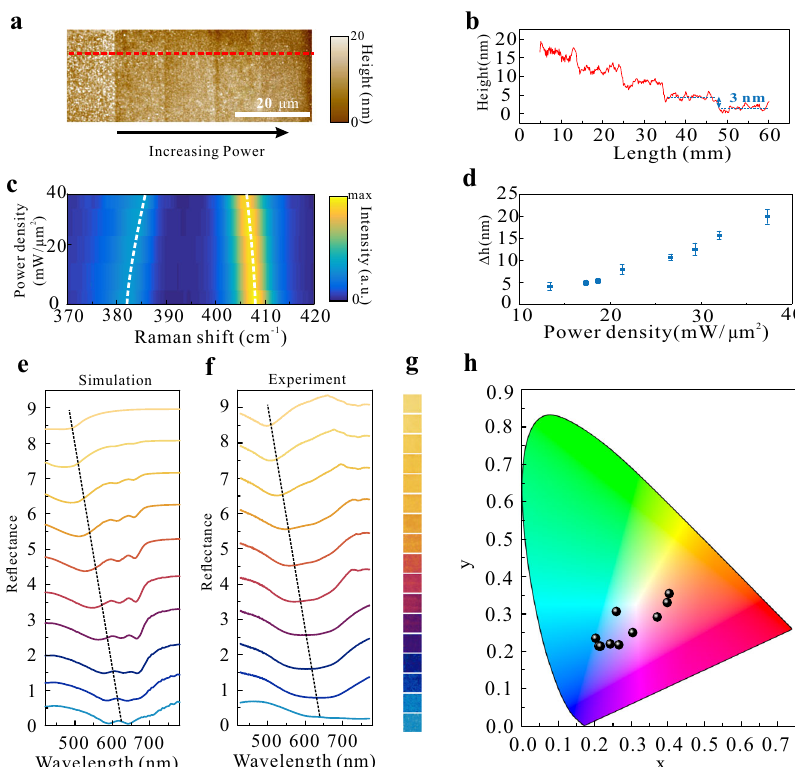
Fig. 2 Laser exfoliating MoS 2 thin fi lms with nanometric thickness precisions. a The AFM image of laser thinned regions obtained at different laser doses. b The height change corresponding to the red dotted line in ( a ). The height of the steps is about 3 nm. c The variation of characteristic Raman spectra of MoS 2 fl akes as the increase of laser powers. d Extracted thickness change from Raman spectra at corresponding laser powers. e , f Re fl ection spectra of MoS 2 thin fi lms prepared on the Au substrate with different nanometric thicknesses. g , h Experimentally obtained re fl ection color palettes and color coordinate diagram through laser exfoliating at variant powers.